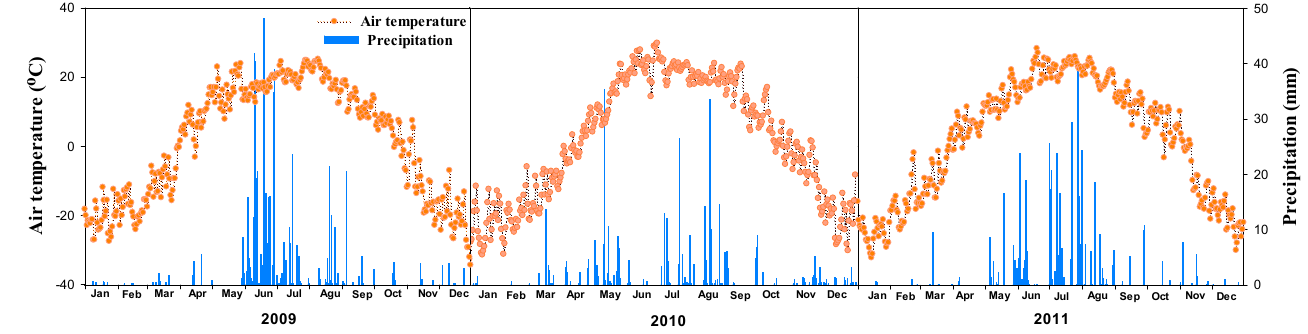
Figure 1. Daily precipitation and average air temperature from 2009 to 2011.